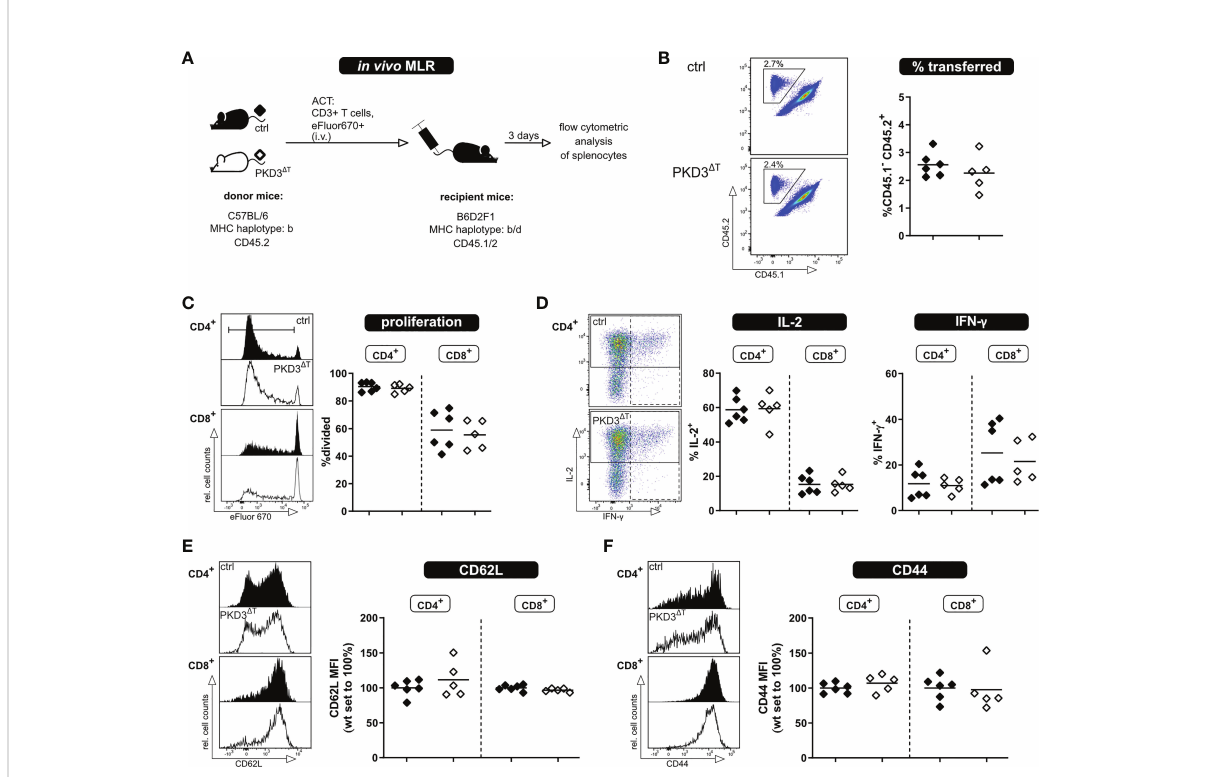
FIGURE 3 T cells from PKD3 D T mice show no impairment in activation, proliferation or cytokine secretion upon allogenic stimulation in vivo. T cells from PKD3 D T mice ( ⬦ ) and respective controls ( ♦ ) were stimulated in an in vivo MLR approach. (A) Experimental set-up (B) Frequency of transferred T cells as well as their proliferation (C) shown with representative FACS dot plots/histograms together with a summarizing graph. (D) Analysis of cytokine expression: Splenocytes from recipient mice were restimulated for 4 h with PDBu/iono together with monensin/brefeldin A. IL-2 and IFN- g were analyzed by fl ow cytometry. (E + F) Median fl uorescence intensity of CD62L and CD44 as surrogate markers for the naïve and effector/memory state of transferred T cells. (n = 5 - 6, from 2 independent